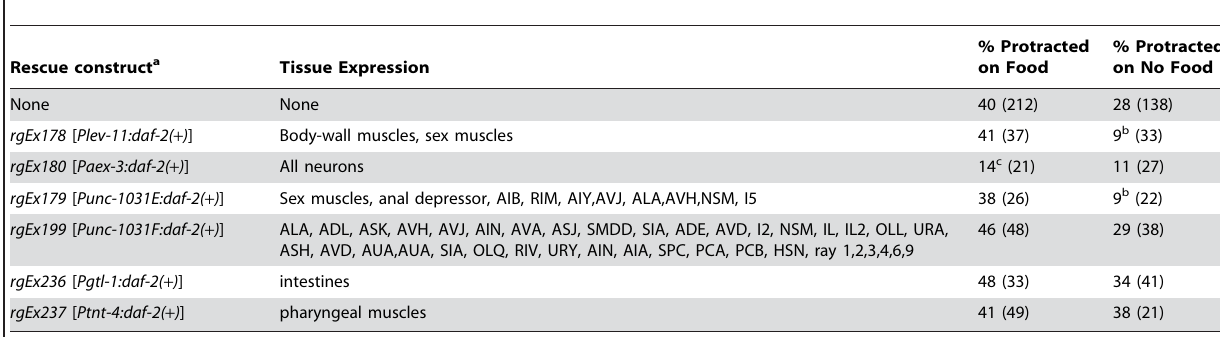
Table 3. Tissue-specific rescues of daf-2(e1368) in daf-2(e1368) unc-103(0)